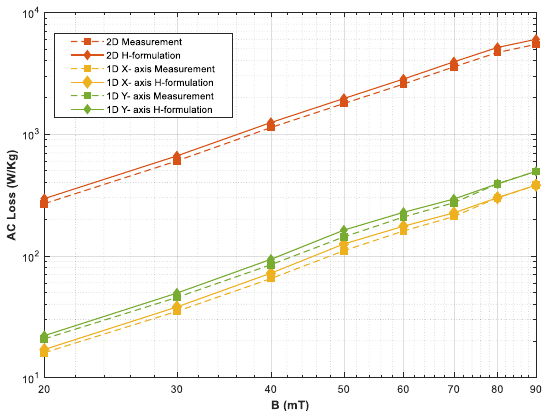
Figure 6. HTS AC loss variations at various alternating and rotating magnetic fields.